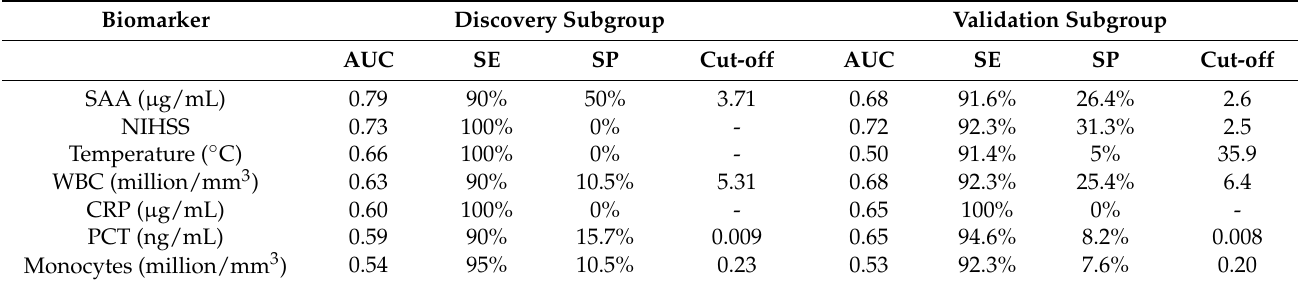
Table 3. AUC, SP and SE values of biomarkers in Discovery and Validation